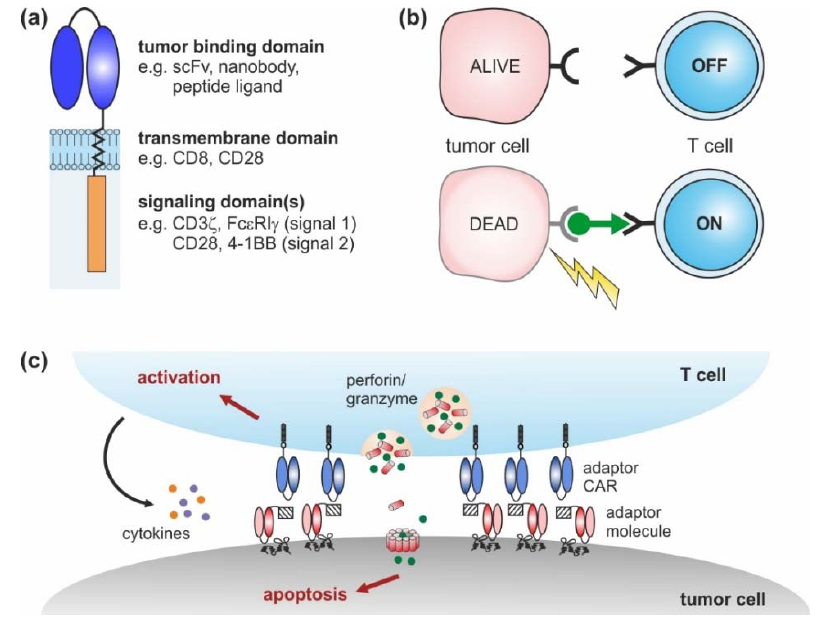
Figure 1. Chimeric antigen receptor (CAR) design: ( a ) conventional CARs are composed of an extracellular tumor binding domain followed by a transmembrane and intracellular signaling domains. ( b ) Adaptor CAR systems are composed of T cells engineered with an adaptor CAR and soluble adaptor molecules (green). Adaptor CAR T cells are per se inactive (OFF). In the presence of tumor-specific adaptor molecules, they are turned ON. ( c ) Upon cross-linkage via adaptor molecules, adaptor CAR T cells elicit potent anti-tumor responses that finally result in tumor lysis.